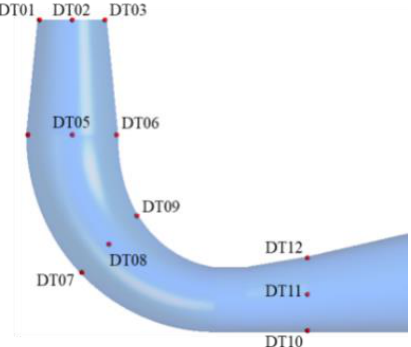
Figure 4. Monitoring points in the draft tube.